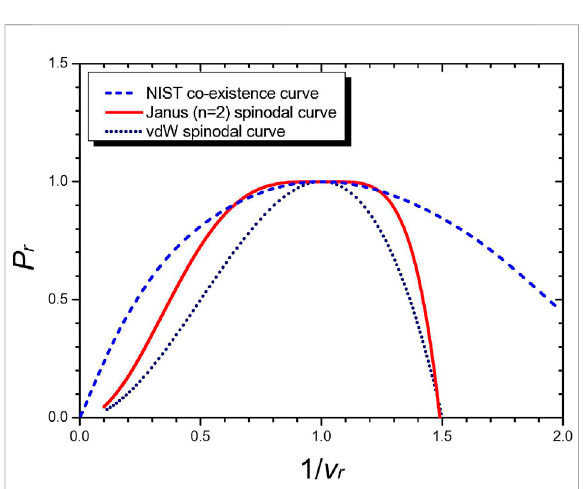
Comparison of the NIST co-existence curve data on cyclopentane (C 5 H 10 ) (blue colored) with the Janus van der Waals spinodal curve (red colored, a = 0.99) and with the original van der Waals spinodal curve (dotted black line). It is a conjecture of Ref. [8] that the liquid – gas co-existence curve should actually coincide with the spinodal curve. Improving our proposed Janus van der Waals equations further, this may be